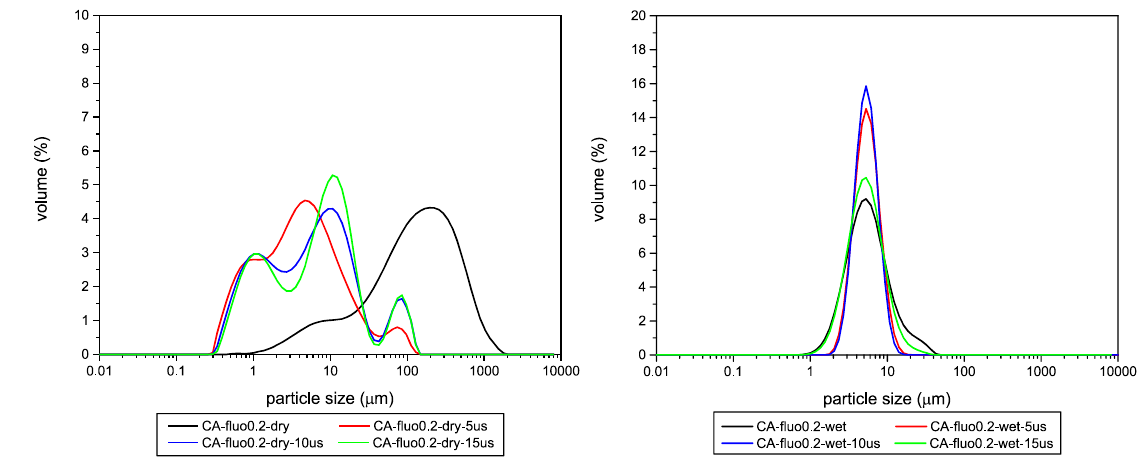
Figure 7. Comparative study of the particle size distribution using dried and wet sample material of sample CA-fluo02.